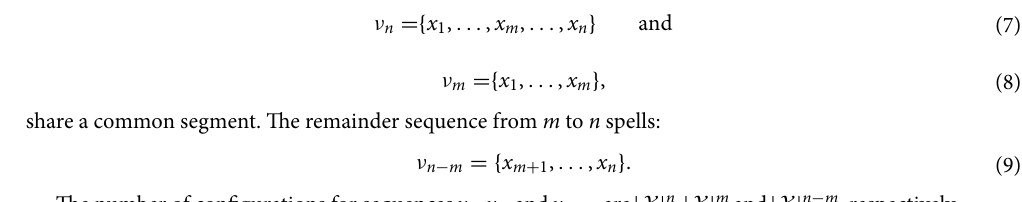
Fig. 1. Given two sequence lengths n > m , the microstates ν n and ν m (see Fig. 1), with respective configurations